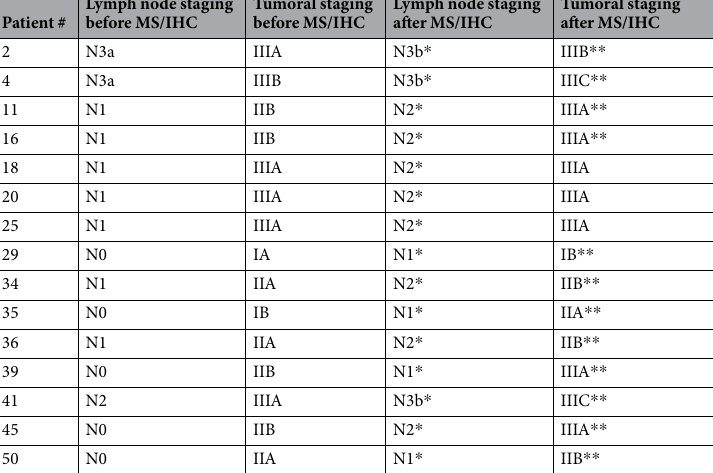
Table 4. Lymph node staging and initial and final tumor staging in the subgroup of patients reestablished after identification of lymph node micrometastases by IHC and MS techniques in gastric carcinoma (n = 15). * Cases where there was a change in the category of lymph node staging, ** Cases in which tumor staging was changed, MS - lymph node multisection, IHC –